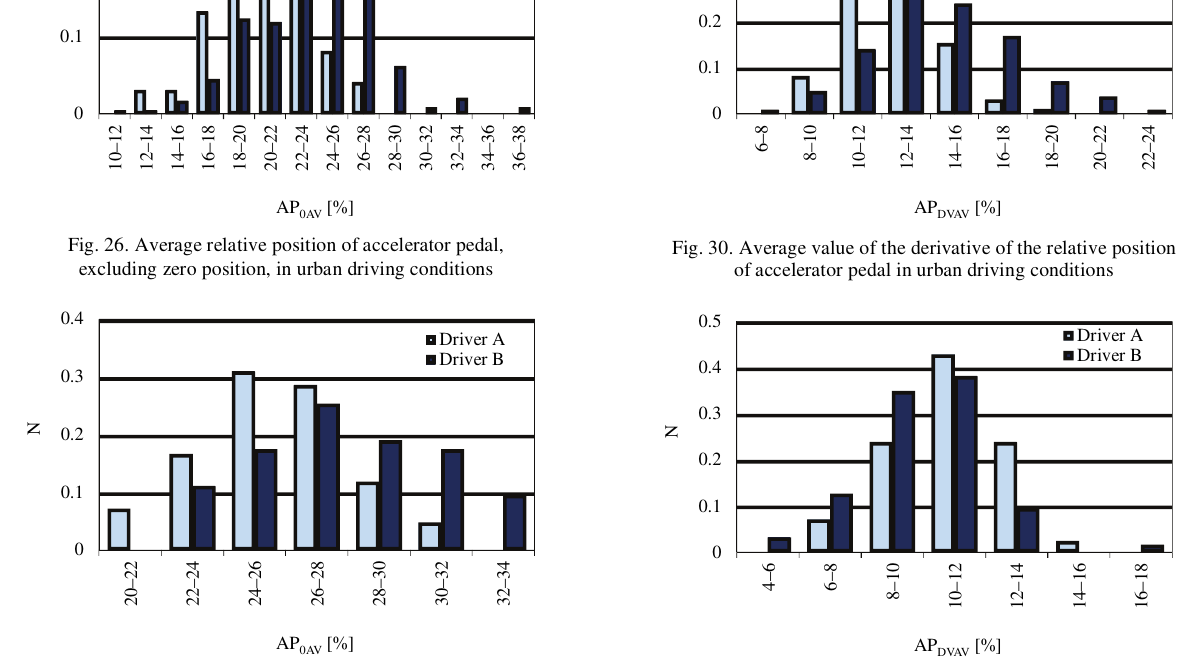
Fig. 31. Average value of the derivative of the relative position of accelerator pedal in extra-urban driving